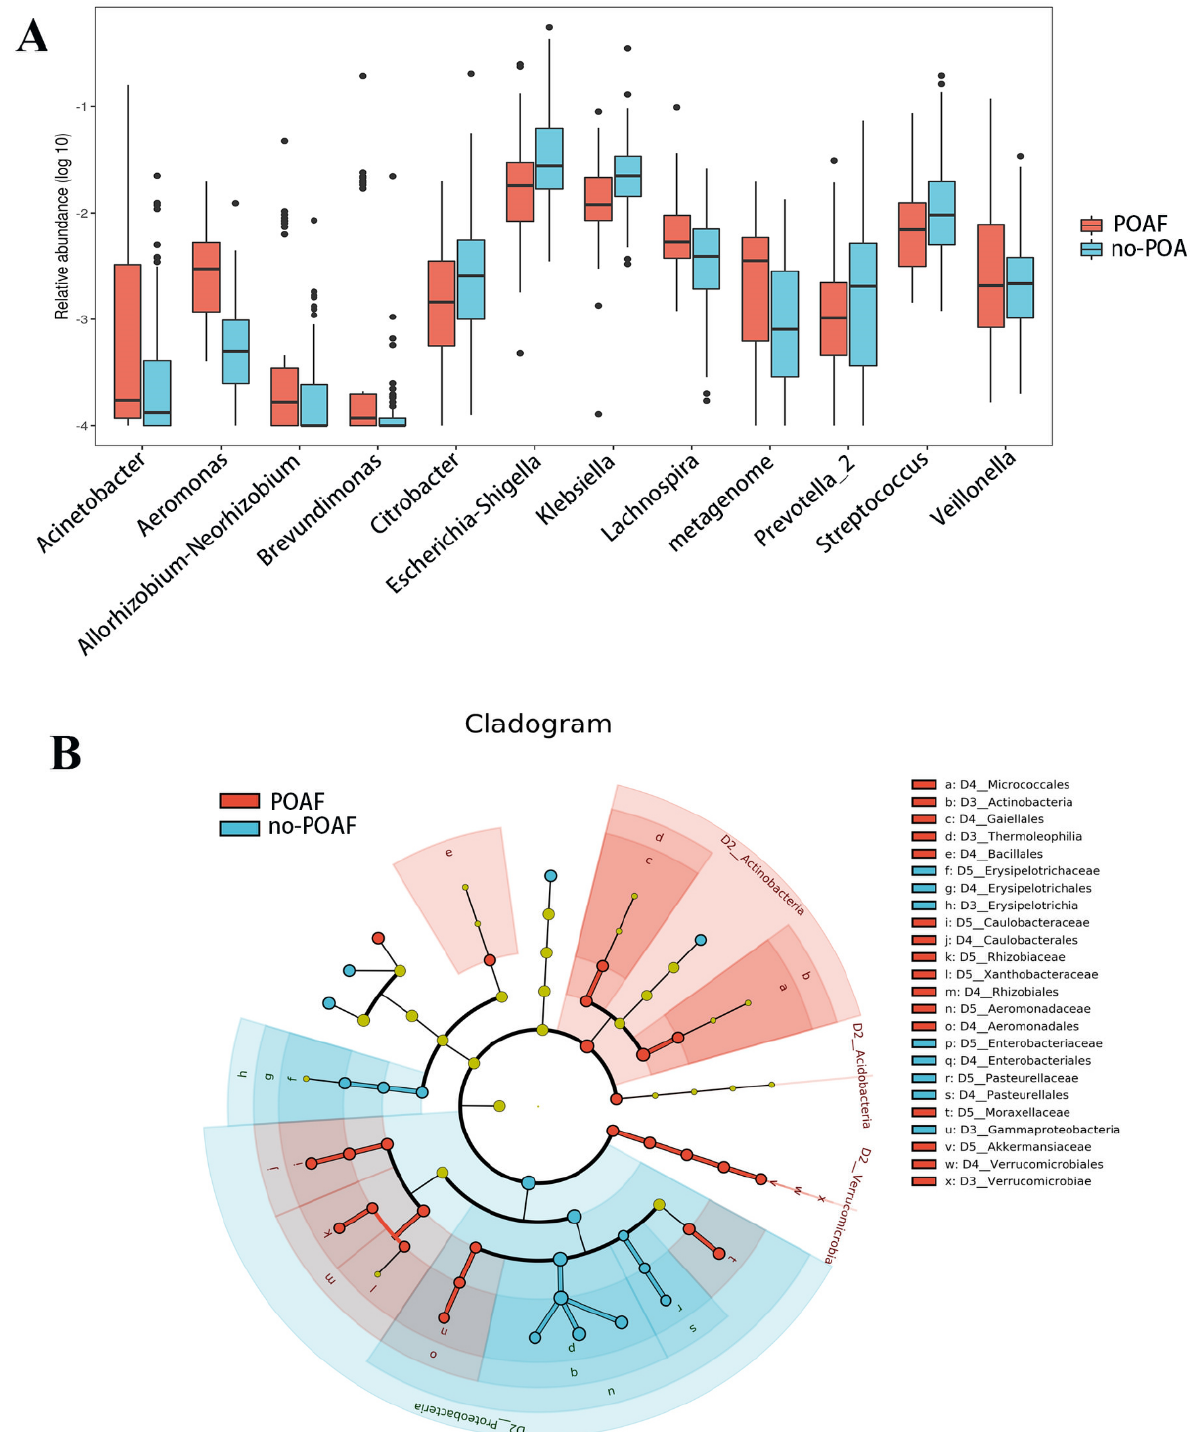
Figure 2. Differences in gut microbiota composition in patients with POAF and without POAF. ( A ) The box plots show the relative abundance of the genus between the two groups. Box, interquartile range; line inside a box, median; dot, outlier. ( B ) The results of linear discriminant analysis effect size (LEfSe) analysis.